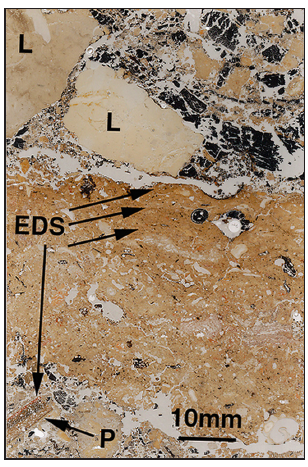
Figure 4: Flatbed scan of thin section (M3B), Str. 14, Op 13-1, west face. Energy dispersive X-Ray spectrometry (EDS) studies were car- ried out on pottery samples and the plaster floor. Scale bar = 10 mm (Photo Richard